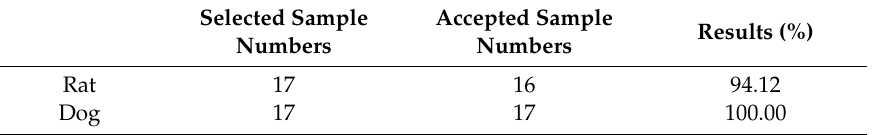
Table 4. Incurred sample reanalysis (ISR) result summary of THAP in rats and dogs. Selected